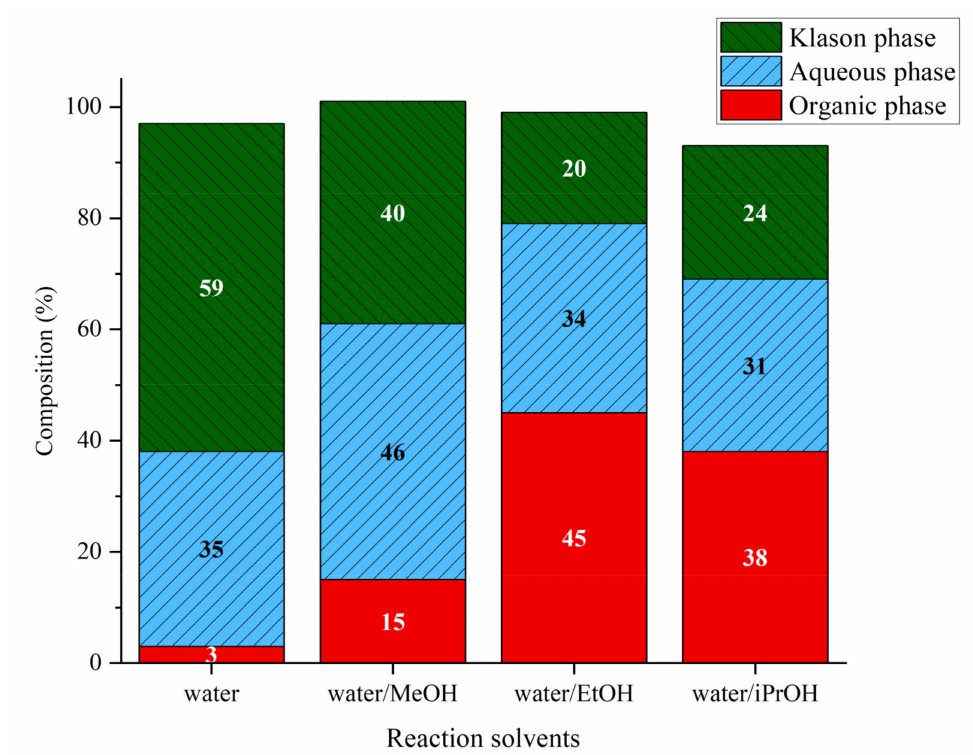
Figure 8. Phase compositions after lignin liquefaction in water/alcohol mixtures. Reaction conditions: Kraft lignin 10 g · kg − 1 , 3 h, 225 ◦ C, 40 bar Ar.